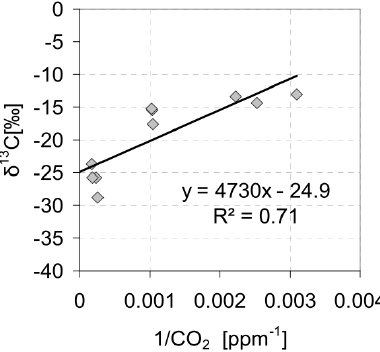
Figure 6. Keeling plot of respiration samples for determination of isotopic ratio of respiration, δ R ; Keeling plot intercept: − 24.9, with a standard error of 1.7‰, within a 95% confidence interval of ± 4.3‰. The solid line indicates the orthogonal regression line. R is the correlation